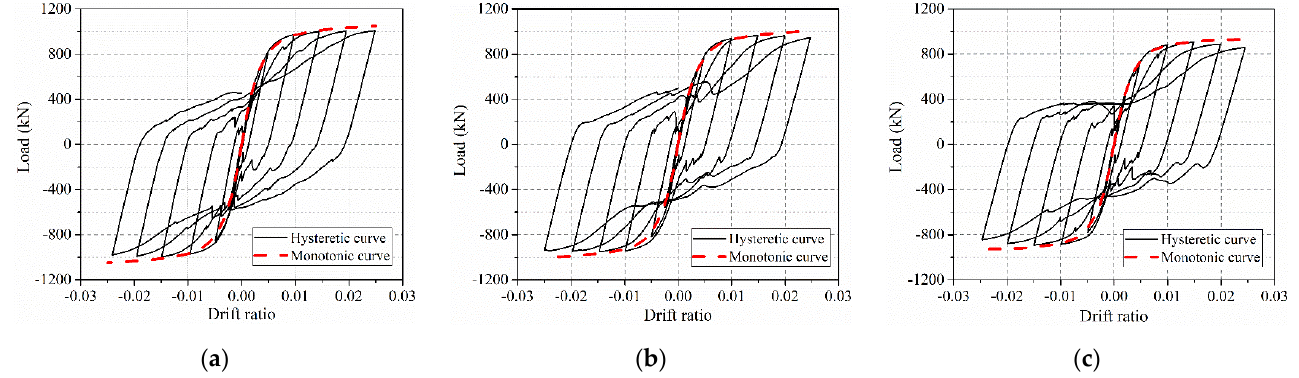
Figure 18. Hysteresis curves for the USPSWs with variable column flexural stiffnesses: ( a ) USPSW2; ( b ) USPSW3; ( c ) USPSW4.